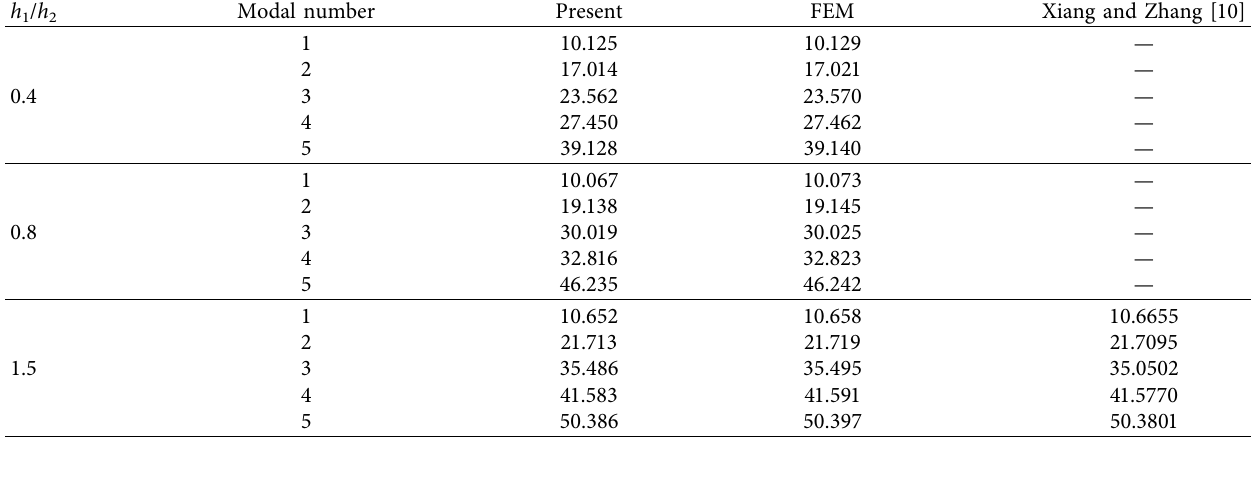
����� 􏽰 ρ h / D for stepped circular Mindlin plate with clamped boundary condition 2 2